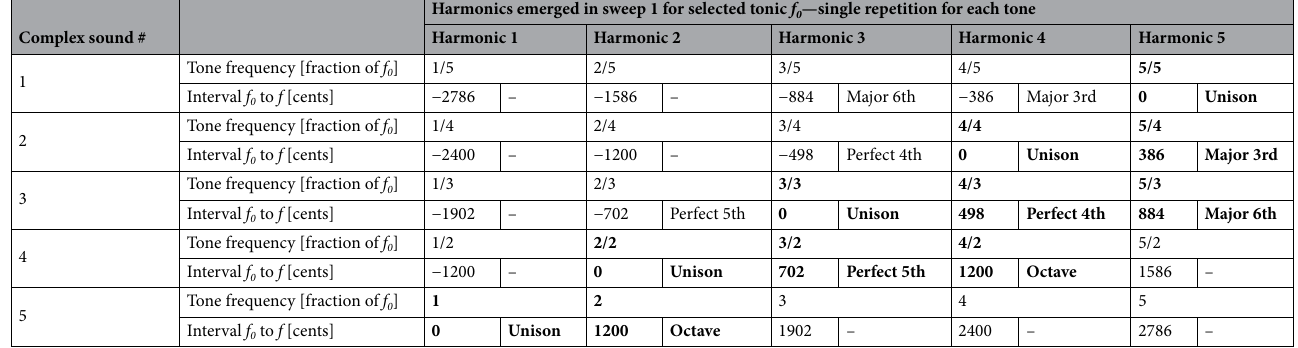
Table 1. Intervals emerged after the end of the first sweep. Only for this explanation, we consider that each sound was presented only once (no repetitions)—this avoids the effects of the synaptic weights adjustments to the obtained results, causing both our- and the Terhardt’s method to predict the same intervals and with the same magnitude of synaptic weights (as a measure for consonance). The intervals with a dark background and white text are in the scope of the octave of interest (where the tonic f 0 is the base tone). The intervals that emerged in the lower octave (where the tonic f 0 is the tone with the highest frequency) are presented with negative cents. The intervals below the lower octave and above the tonic’s octave are